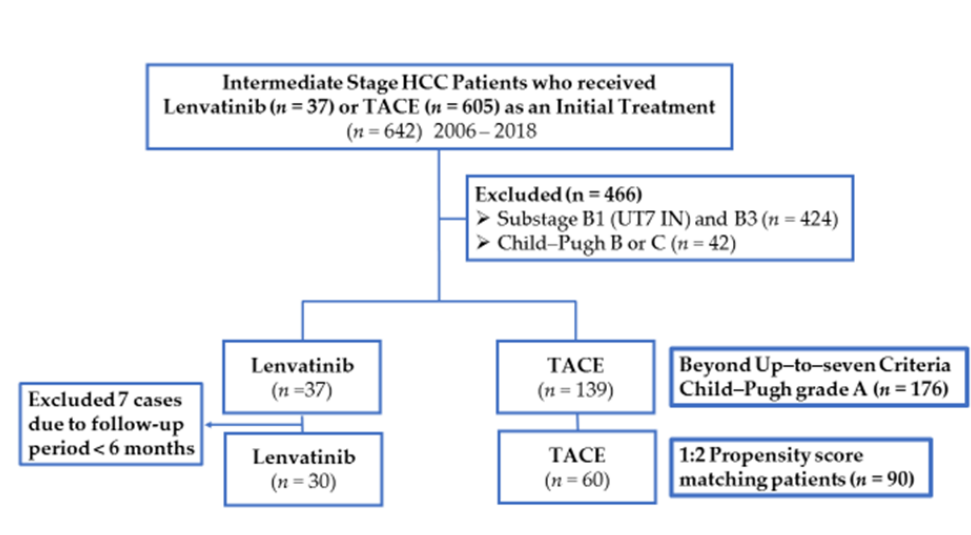
Figure 1. Patients enrolled in this study. A total of 642 patients received lenvatinib or TACE as an initial treatment for intermediate stage HCC between 2006 and 2018. Of them, 37 lenvatinib-treated patients and 139 TACE-treated patients met the eligibility criteria of this study, which is patients with Child–Pugh A liver function and tumor burden of beyond up-to-seven criteria. After propensity score matching, e ffi cacy was compared between 30 lenvatinib-treated patients and 60 TACE-treated